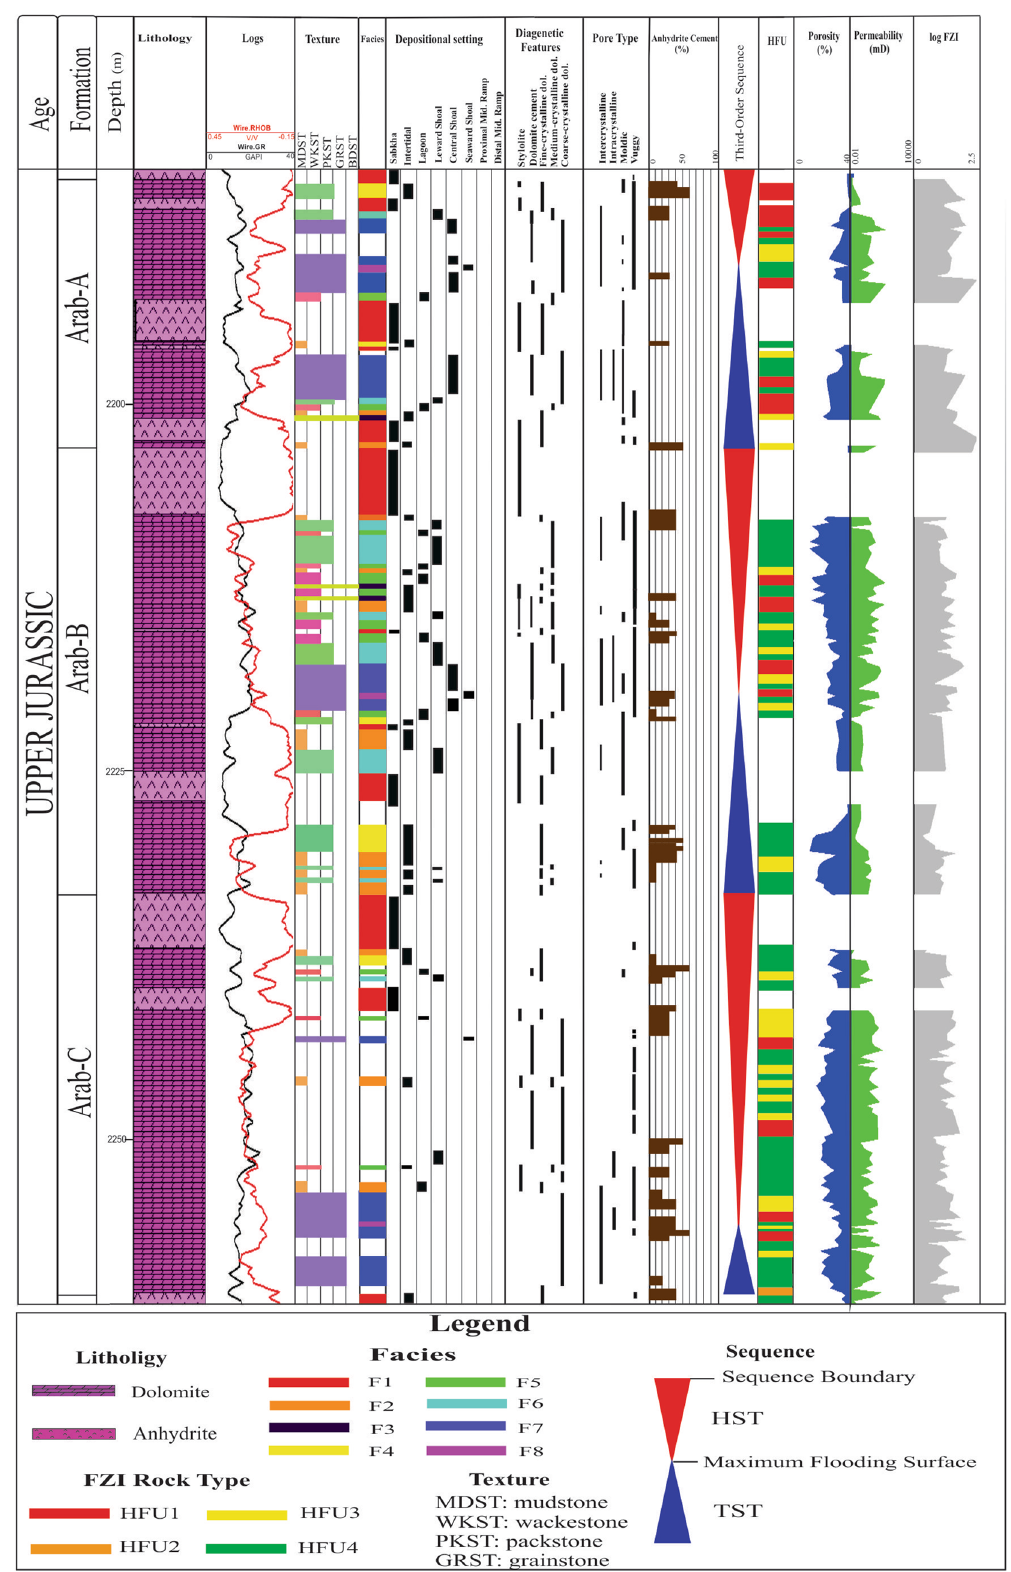
Fig. 13 Correlation between different parameters including depositional, diagenetic and HFUs in a sequence stratigraphic framework in B-01